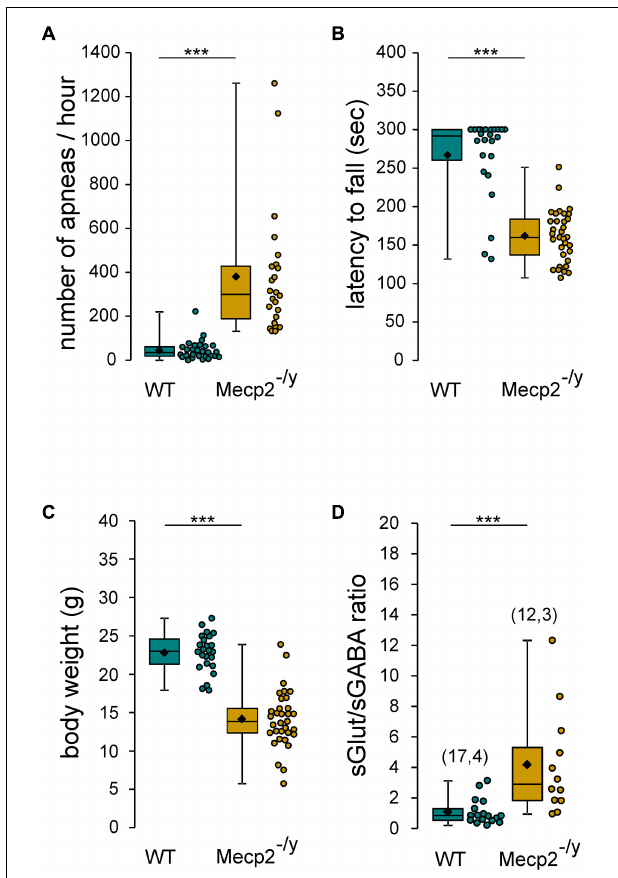
FIGURE 1 | RTT features of Mecp2 - / y mice. Box plots of the number of apneas (A) , latency to fall from rotarod (B) , body weight (C) , and sGlut/sGABA frequency ratio (D) of 7–8 weeks-old wild-type (WT) and Mecp2 - / y mice. In this and following figures, box plots represent quartiles, whiskers show data range, lozenges represent arithmetic means, scatter plots show individual data points, and numbers in parentheses indicate the number of neurons/slices recorded and the number of mice used. *** P < 0.001, two-tailed Mann–Whitney U